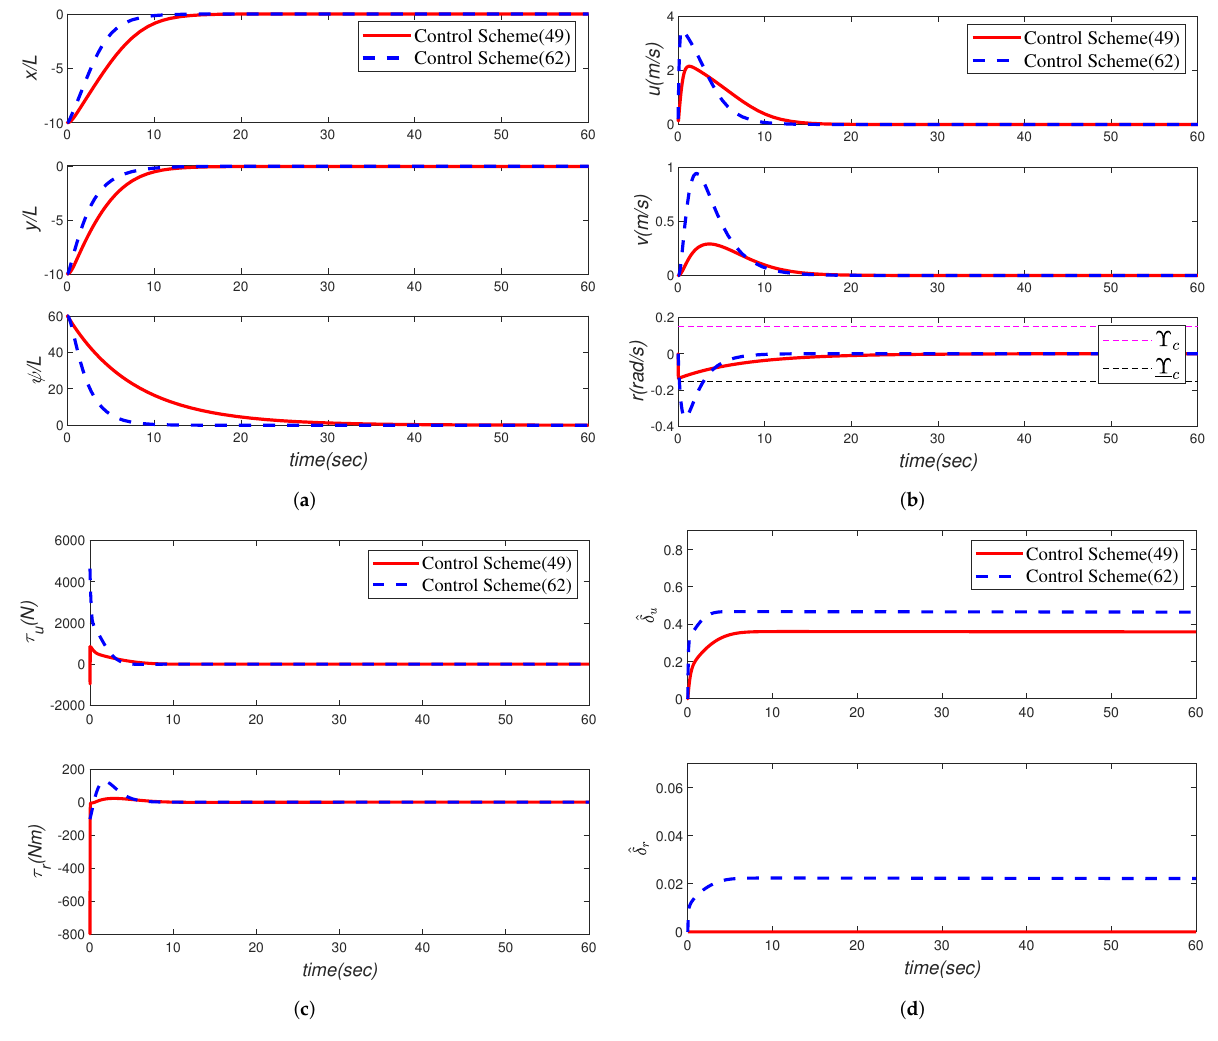
Figure 3. Comparisons of between control scheme Equation (49) and control scheme Equation (62). ( a ) Comparisons of x , y and ψ . ( b ) Comparisons of u , v , and r . ( c ) Comparisons of τ u and τ r . ( d ) Comparisons of ˆ δ u and ˆ δ r .